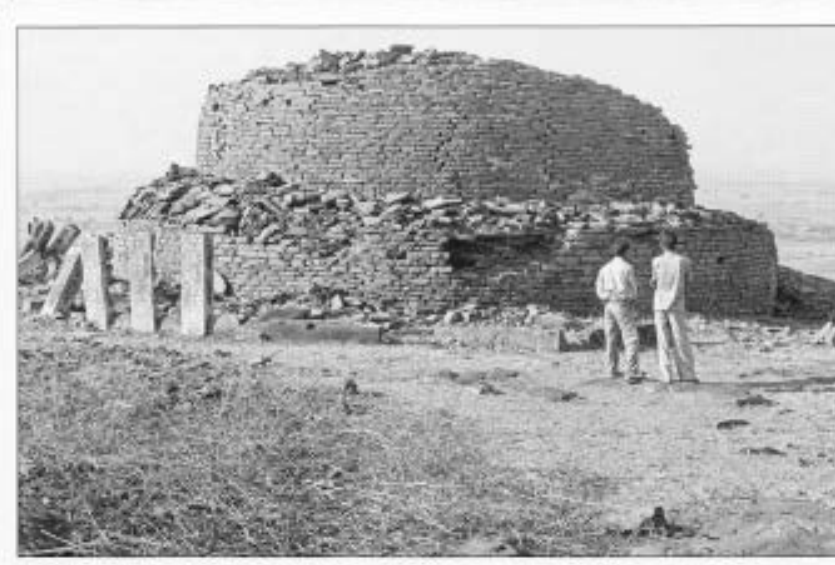
Figure 4 Stupa remains on Andher hill, c. second century BC